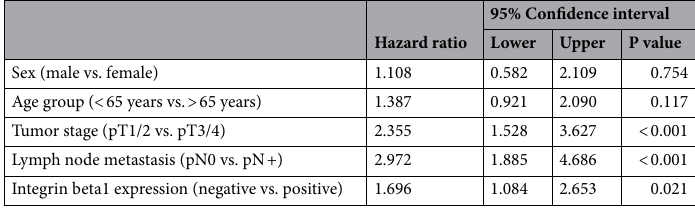
Table 2. Multivariate cox-regression analysis for patients after primary surgery.